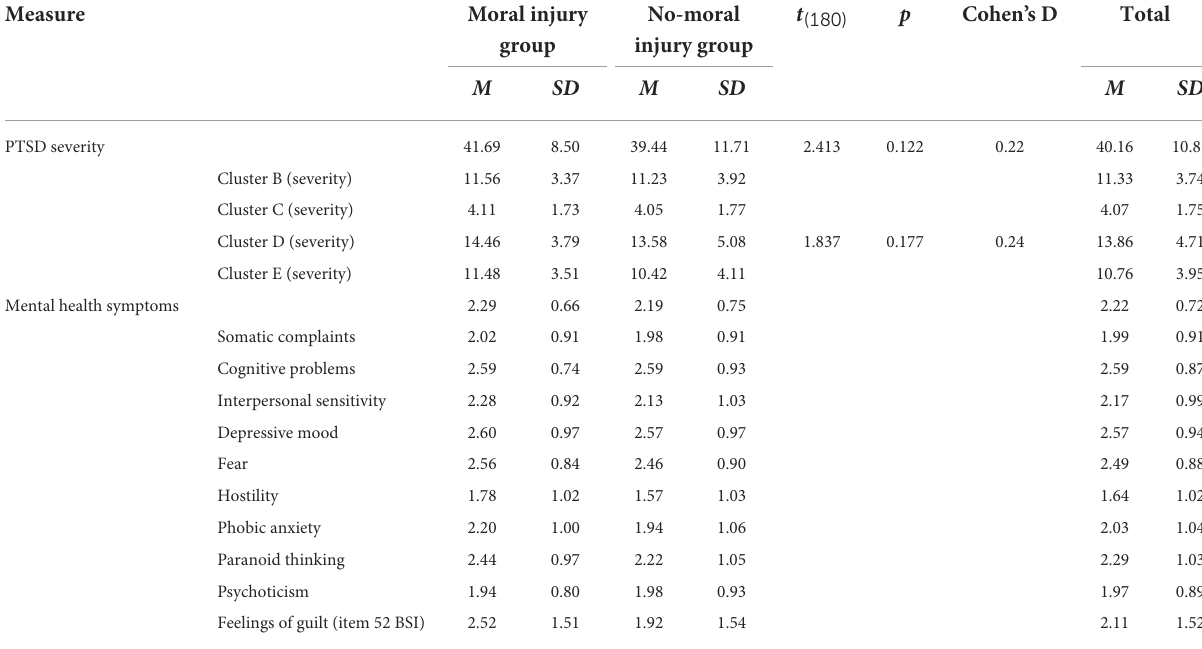
TABLE 3 Descriptive statistics of PTSD severity symptoms and mental health symptoms. Measure Moral